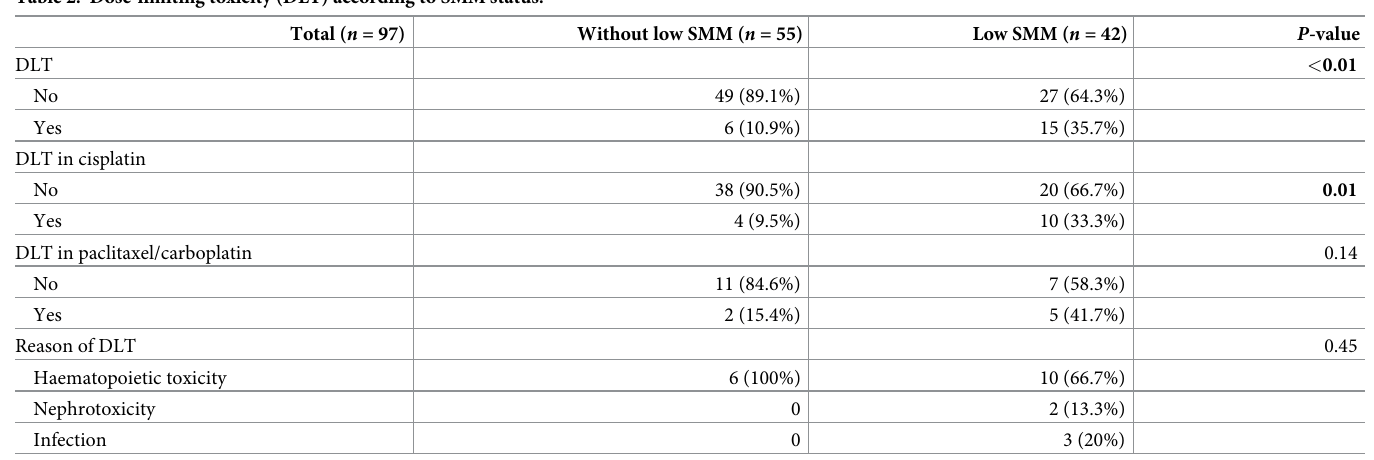
Table 2. Dose-limiting toxicity (DLT) according to SMM status.